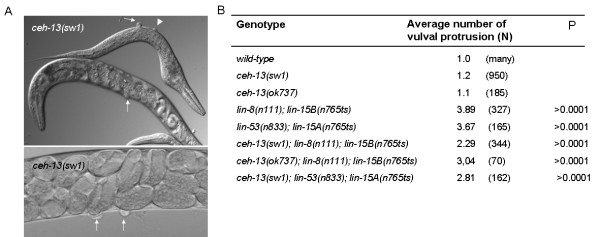
ceh-13 affects vulval patterning. A, Vulval morphology in ceh-13(-) mutant hermaphrodites. White arrows indicate vulval protrusions (protruded vulval phenotype; Pvl), the arrowhead indicate an ectopic vulva (top). ceh-13(-) mutants exhibit variable vulval morphologies, including Pvl (8%), Multivulva (Muv; 0.2%) and Egg-laying defective (Egl; 14%) phenotypes (N = 200). B, Mutational inactivation of ceh-13 decreases vulval induction in synMuv AB double mutant animals. For each triple mutant: P < 0.001; for statistics, see the Material and Methods. lin-8 and lin-15A are class A synMuv genes, while lin-53 and lin-15B are class B synMuv genes. Single mutants defective in either of the synMuv A or B pathways have normal vulval morphology (data not shown), whereas synMuv AB double mutant are Muv. Wild-type animals actually have no vulval protrusion (their normal vulval structure is considered as 1 protrusion in the figure).